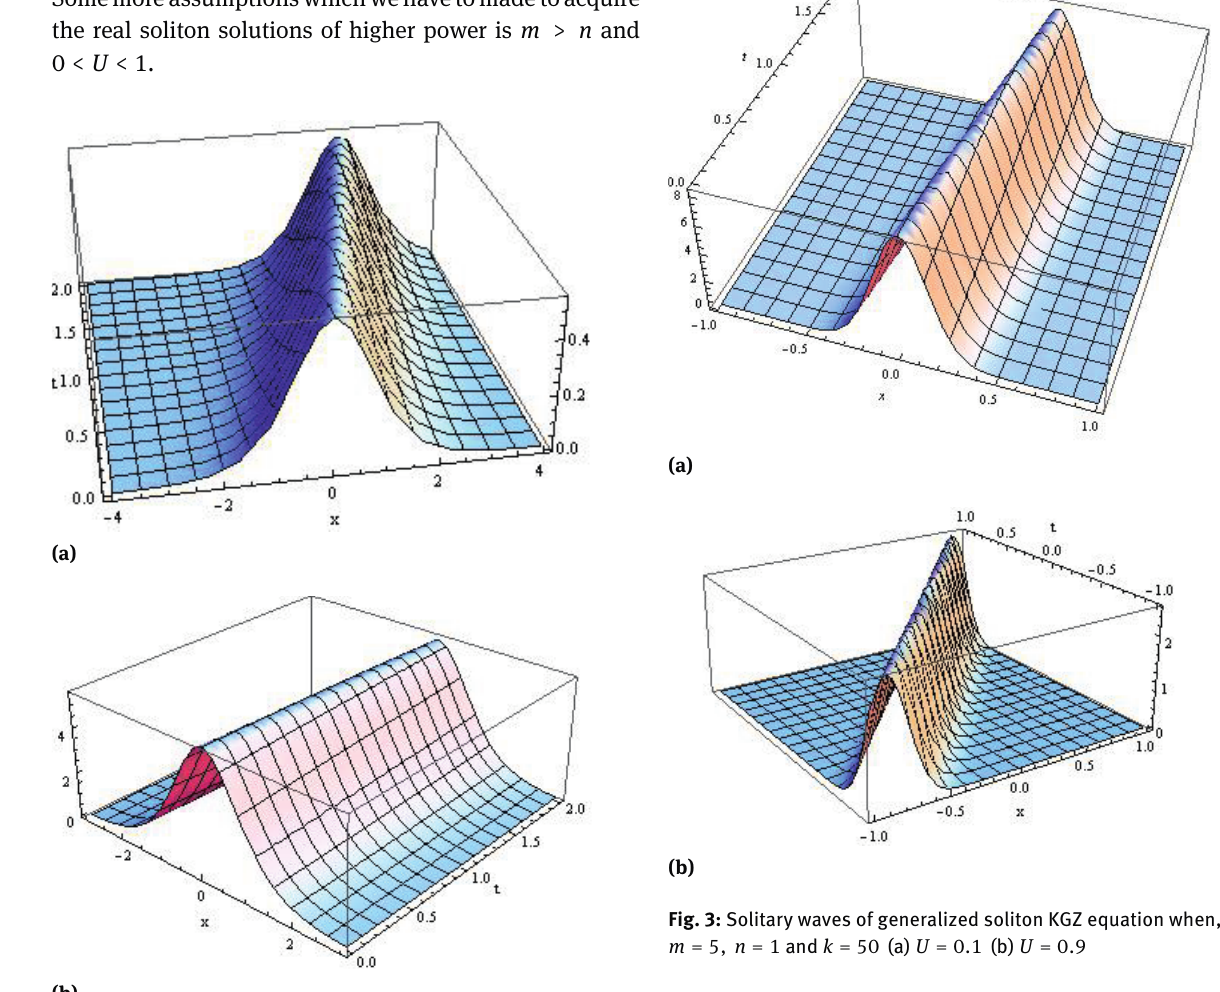
Fig. 2: Solitary waves of 2 nd soliton KGZ equation when, (a) U = 0.1 (b) U = 0.9